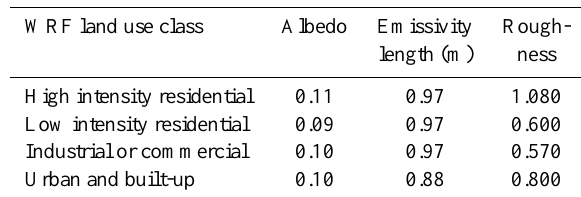
Table 2. Satellite-derived land surface parameters for the city of Athens, Greece, used in the WRF/Noah modeling